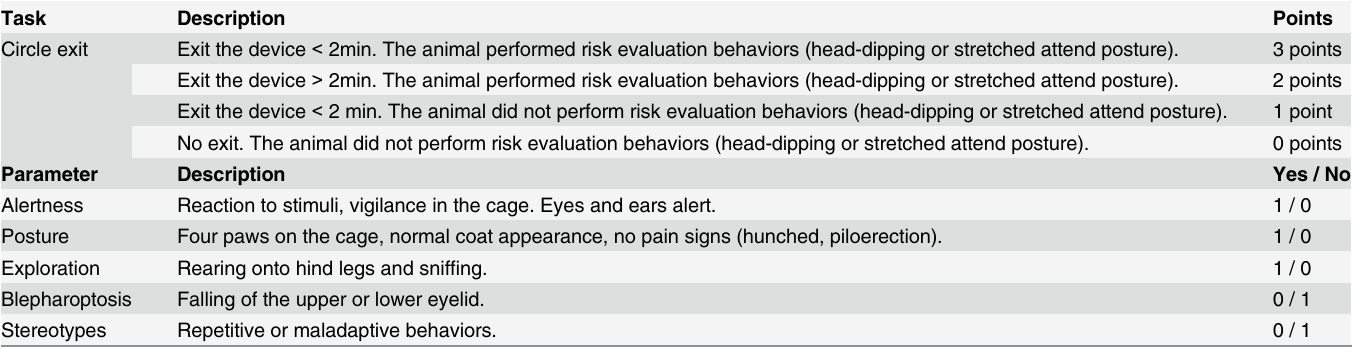
Table 1. Neurological Score test for mice. Circle exit task and physiologic